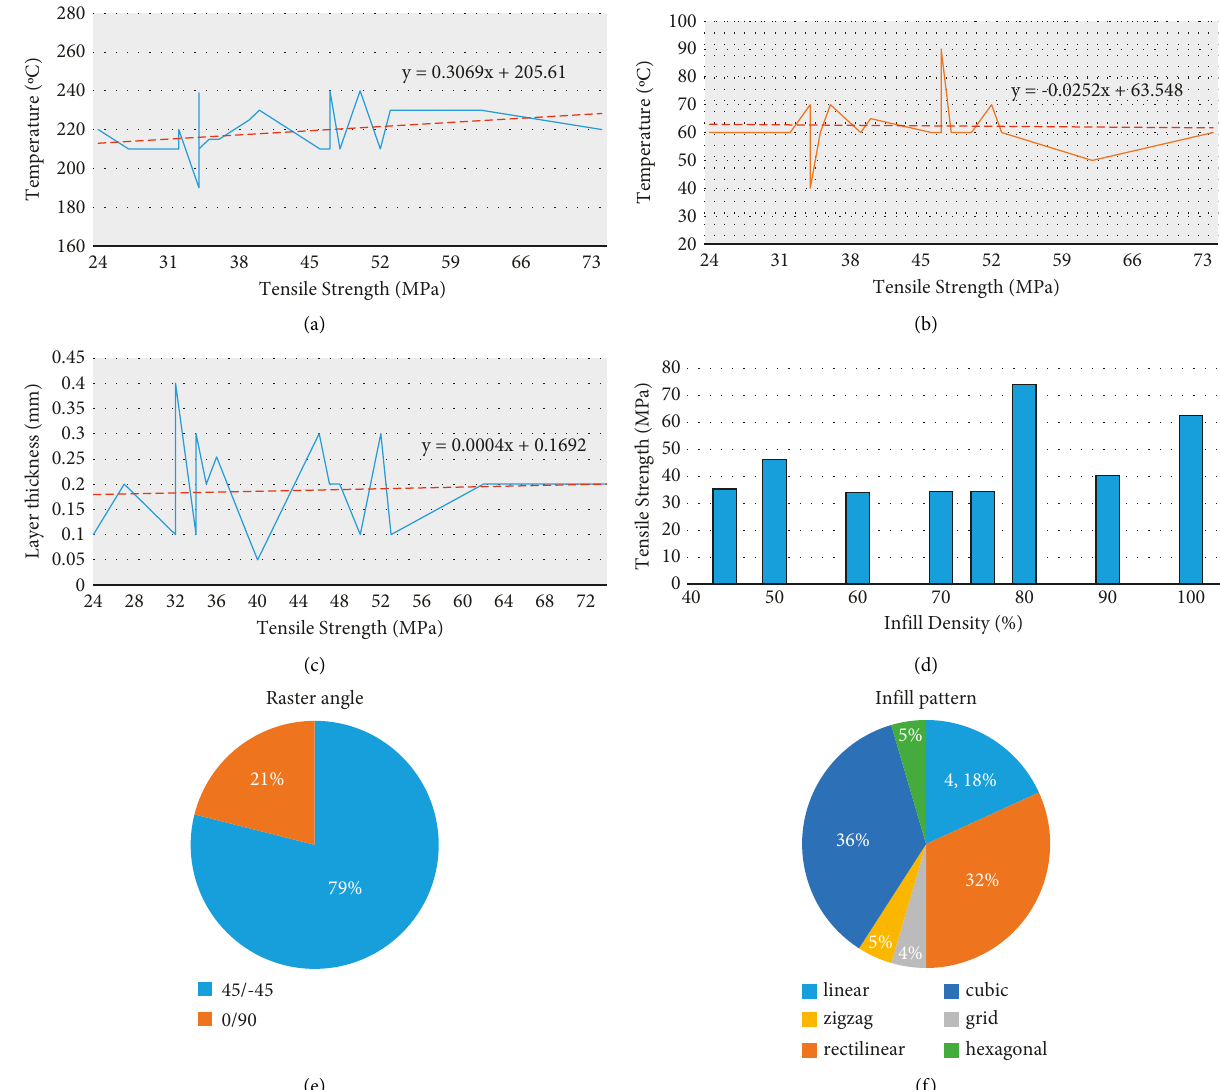
y = 0.3069x + 205.61